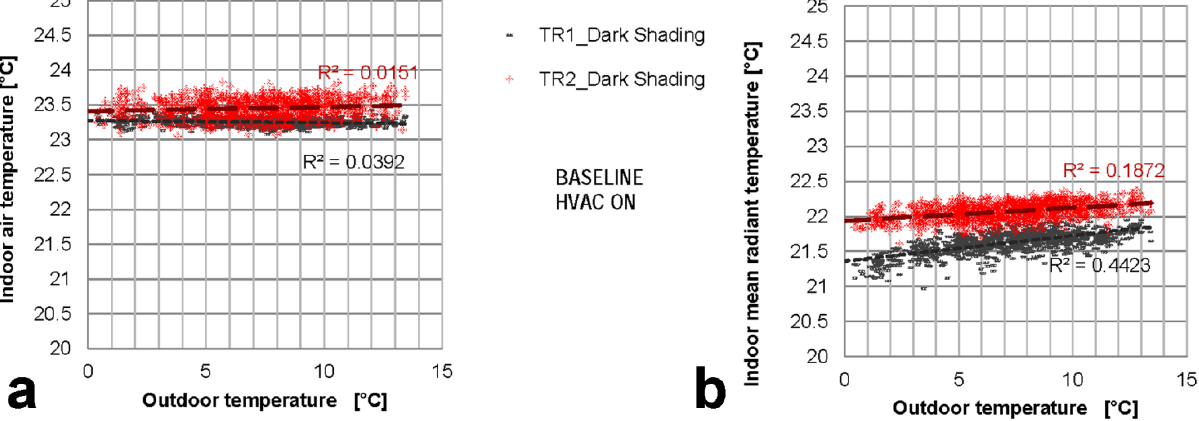
Figure 5. Indoor thermal behavior of the test-rooms before the implementation of the Cool Shading systems in TR2. Indoor air temperature trends ( a ), and mean radiant temperature trends ( b